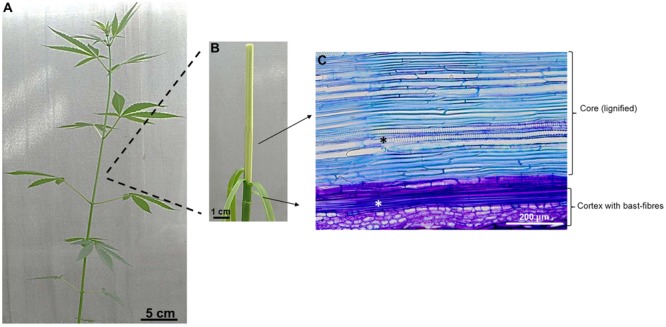
Anatomical details of Cannabis stem. (A) Stem of an adult plant (ca 2 months); (B) The stem can be peeled off and shows a lignified core and a cortex with bast fibers. (C) Longitudinal section of hemp stem stained with toluidine blue showing the cortex with a bundle of bast-fibers (white asterisk) and the core with xylem vessels (black asterisk).